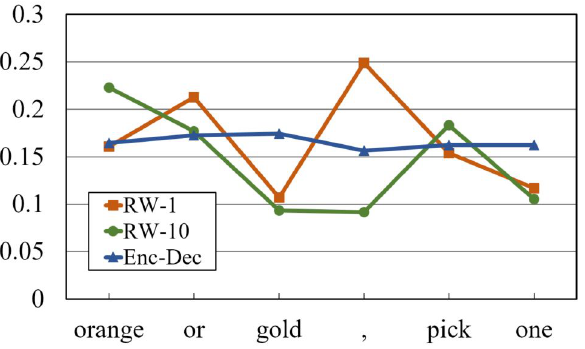
Figure 3. The distributions of the attentions for an example query and response. The distributions are obtained from the proposed response weight and the standard